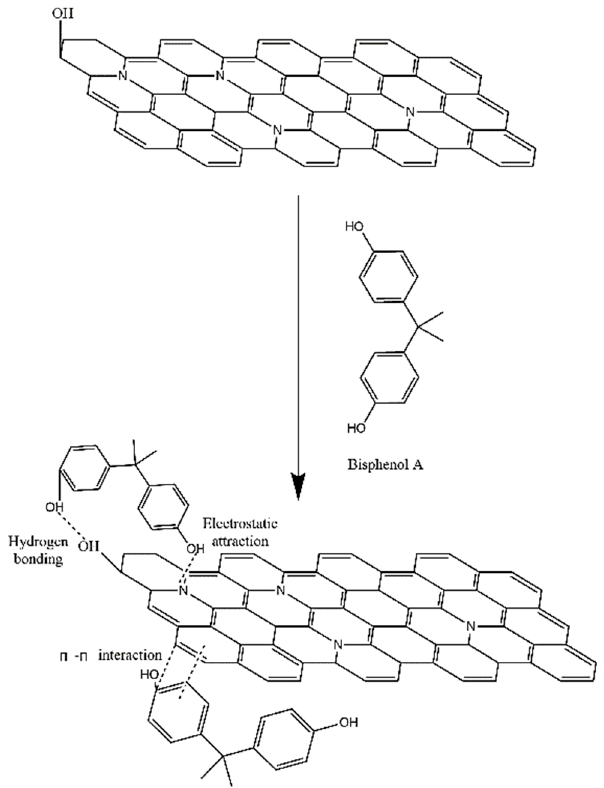
Figure 13. Schematic of adsorption interaction of bisphenol A (BPA) onto N-GLPs 750 6 .